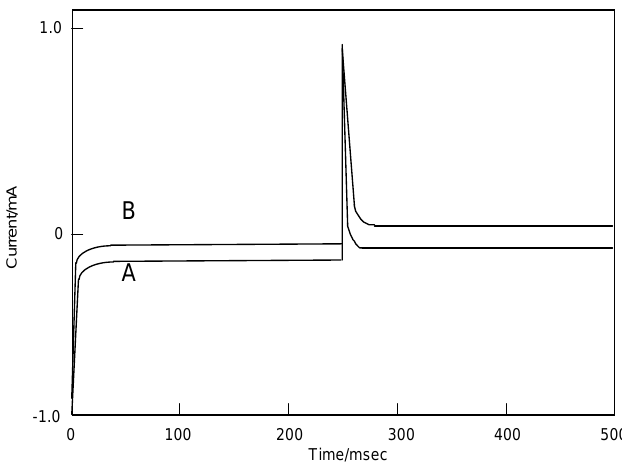
Figure 8. Chronoamperometry of cobalt phthalocyanine tetrasulfonic acid. (A) Potential step; -1.2–0.0 V vs. Ag/AgCl, step width: 250 ms. (B) Potential step; -1.2–1.6 V vs.